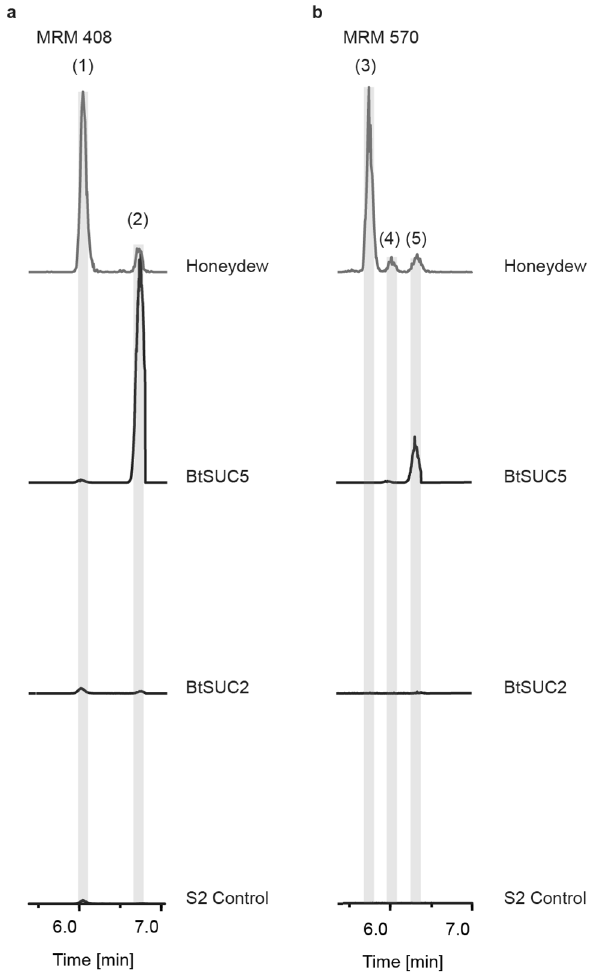
Figure 7. Chromatographic analyses of glucosylated products catalyzed by the B. tabaci transglucosidases BtSUC2 and 5. Medium of Drosophila S2 cells expressing these enzymes was assayed with linamarin and sucrose. Depicted are extracted multiple reaction monitoring (MRM) LC–MS chromatograms for mono- and di-glucosylated linamarin derivatives. ( a ) BtSUC2 and 5 showed transglucosidation activity, producing α-(1 → 4)-linked glucose derivatives ( 2 ) of linamarin with BtSUC2 also producing small amounts of the α-(1 → 6)-linked derivative ( 1 ) above control levels. ( b ) BtSUC5 additionally produced the diglycosylated product ( 5 ). The S2 control assay was performed on medium extracts of untransformed S2 cells. ( 1 : α-(1 → 6)- linked glucose derivative of linamarin; 2 : α-(1 → 4)-linked glucose derivative of linamarin; 3 : α-(1 → 6), α-(1 → 6)- linked diglucosylated derivative of linamarin; 4 , 5 : unknown diglucosylated derivatives of